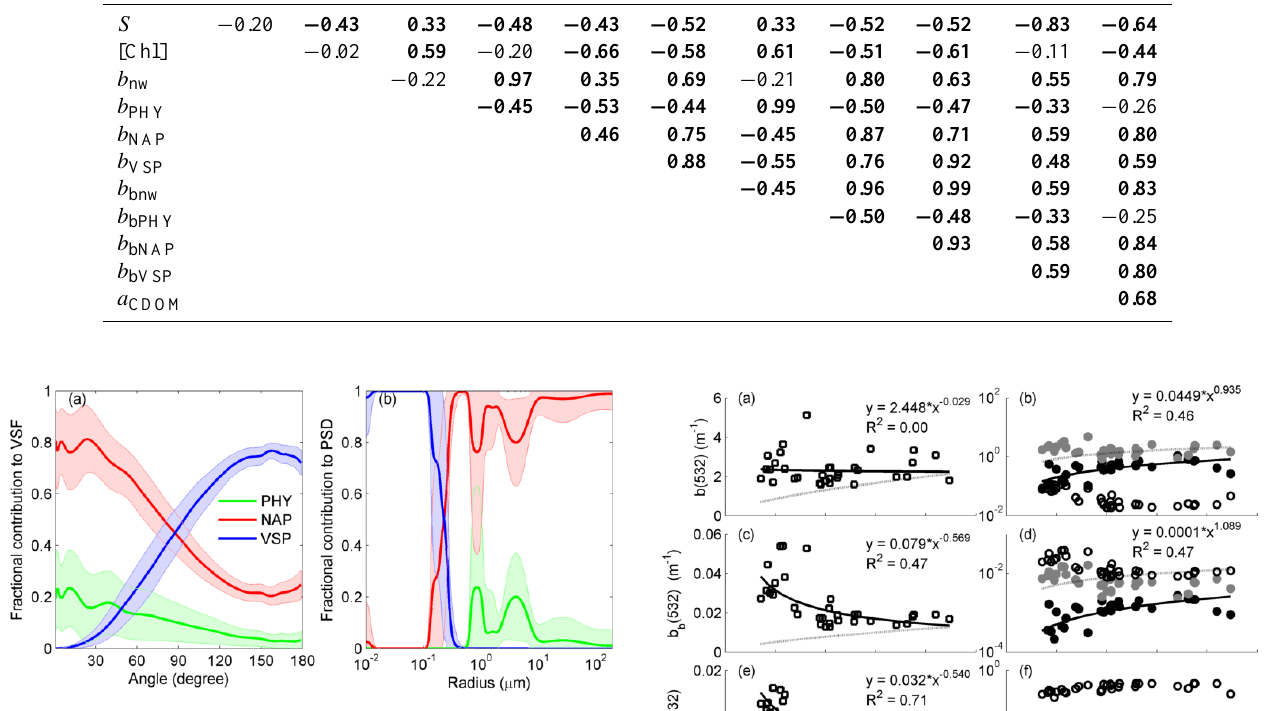
Fig. 5. Average fractional contributions by each of the three particle groups to (a) the VSF and (b) the PSD. The shaded areas represent one standard deviation.